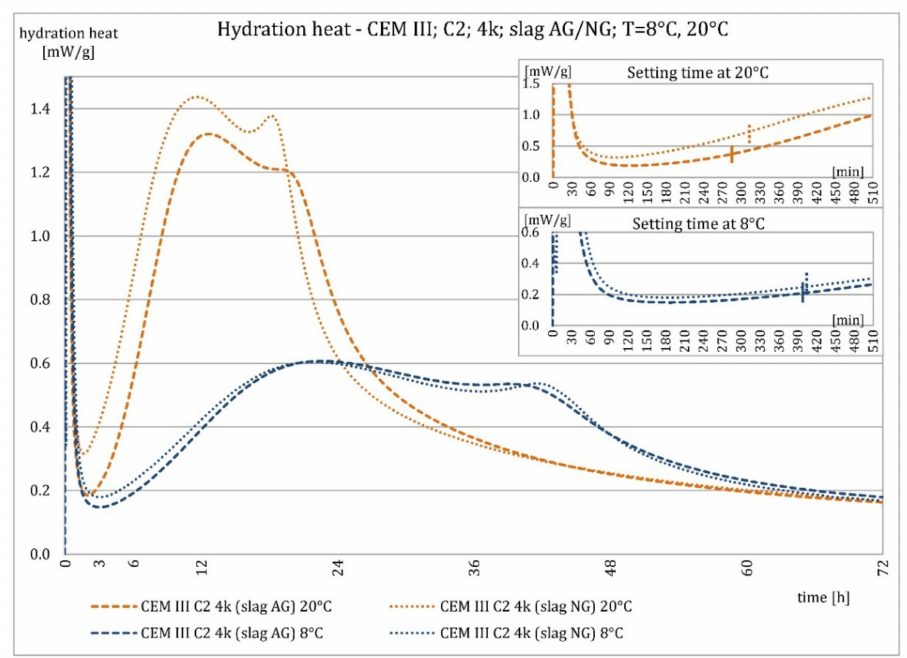
Figure 14. Hydration heat of C2 clinker based non-modified cement CEM III/A, containing slags differing in fineness at 8 ◦ C and 20 ◦ C.